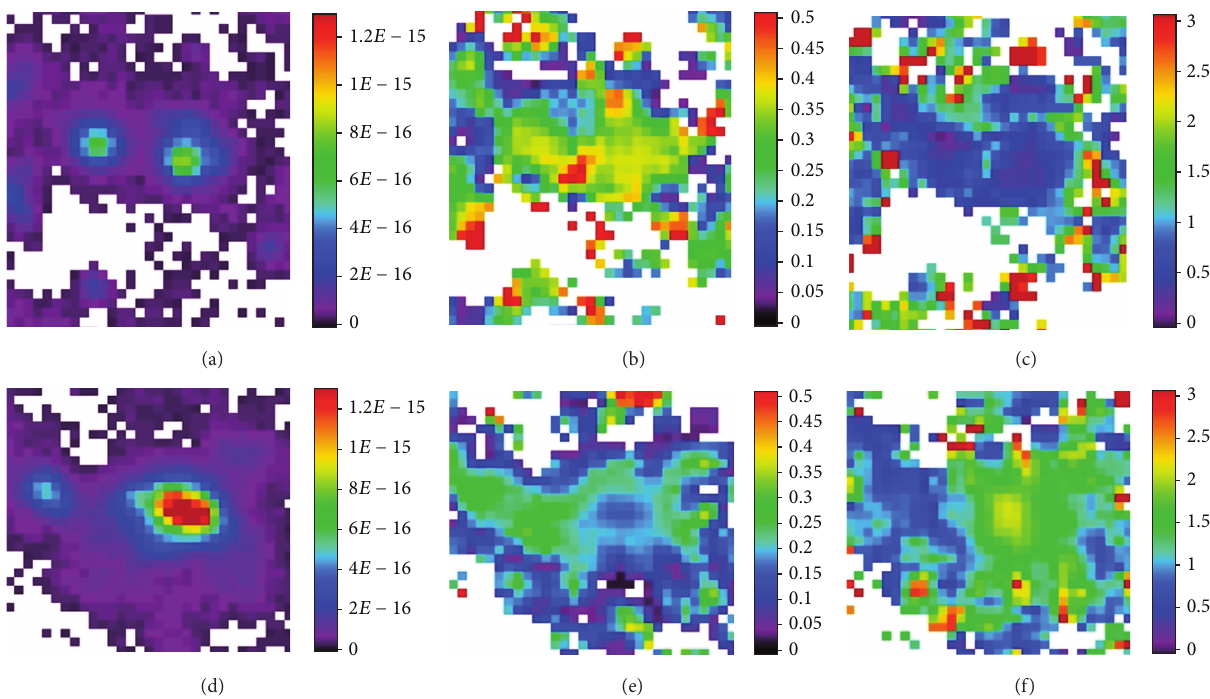
Figure 7: Images of HII regions located at RA = 1h36 m38.9 s, DEC = 15d 44m 24.8 s with 12 + log (𝑂/𝐻) ∼ 8.4 ((a), (b), and (c)), and at RA = 1h36 m38.4 s, DEC = 15d 47 m00.9 s with 12 + log (𝑂/𝐻) ∼ 8.8 ((d), (e), and (f)). In both cases, the image on the left shows the H 𝛼 maximum intensity [ergs −1 cm −2 ], center: [NII] 𝜆 6584/H 𝛼 , right: [OIII] 𝜆 5007/H 𝛽 . FOV is 33 󸀠󸀠 × 33 󸀠󸀠 , North at the top, East to the left.